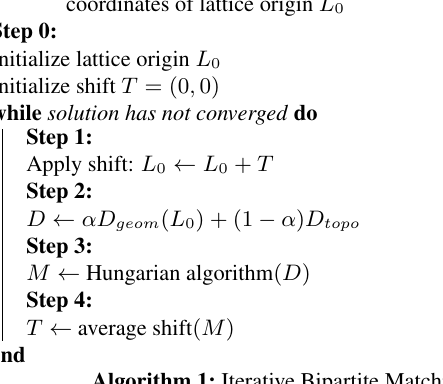
Algorithm 1: Iterative Bipartite